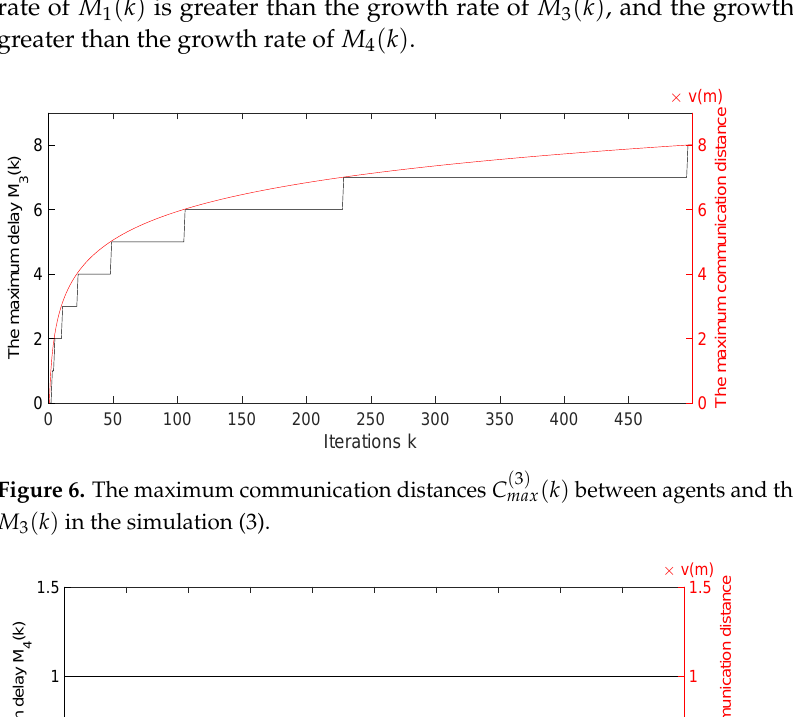
rate of M 1 ( k ) is greater than the growth rate of M 3 ( k ) , and the growth rate of M 3 ( k ) is greater than the growth rate of M 4 ( k ) .